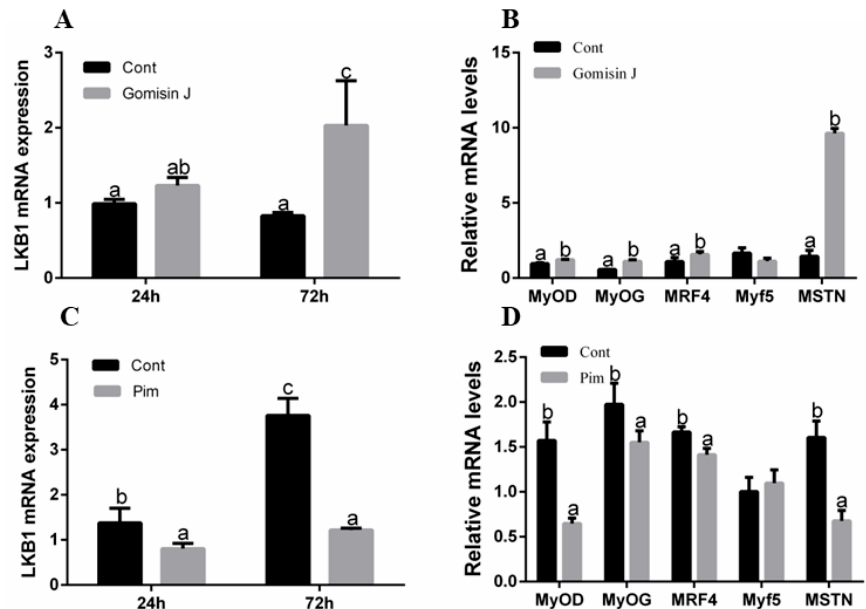
Figure 3. The effects of Gomisin J and Pim on triploid crucian carp muscular LKB1 and myogenic factor expression at different time points. ( A ) The effects of Gomisin J on LKB1 expression at different time points. ( B ) The effects of Gomisin J on MyoD, MyoG, MRF4, Myf5 and MSTN1 expression at 72 h. ( C ) The effects of Pim on LKB1 expression at different time points. ( D ) The effects of Pim on myogenic factor (MyoD, MyoG, MRF4, Myf5 and MSTN1) expression at 72 h. Data are presented as means ± SE ( n = 3). Different letters indicate significant differences ( p < 0.05).